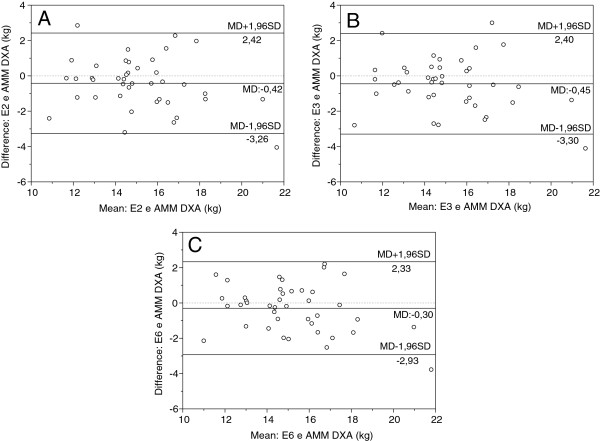
Agreement between equations developed and criterion method. E2 = equation 02; E3 = equation 03; E6 = equation 06; AMMDXA = dual energy X-ray absorptiometry; MD = Mean differences, SD = standard deviation.